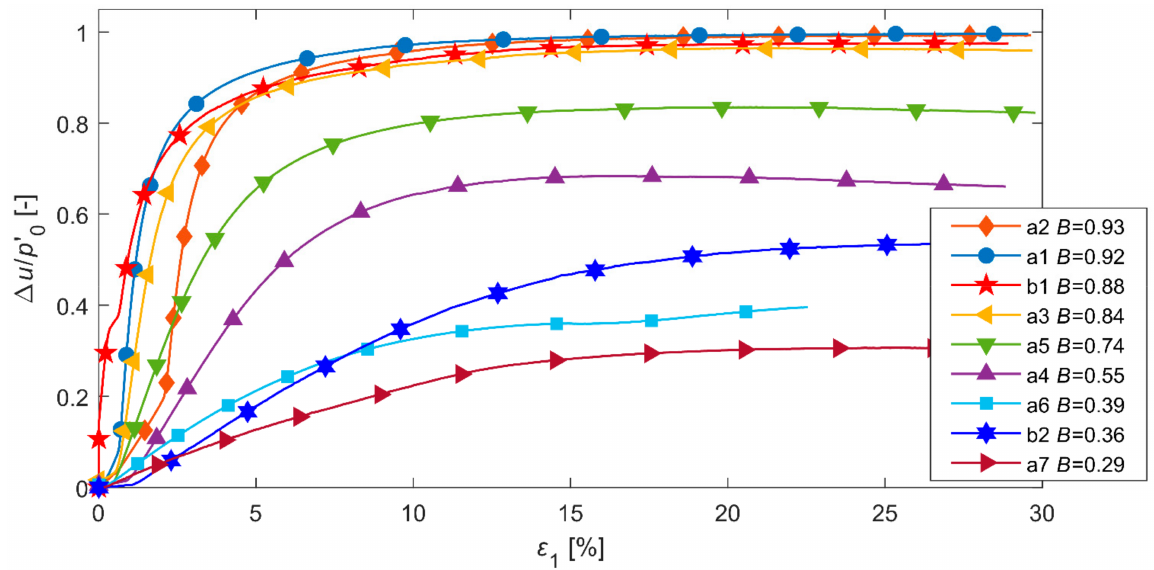
Figure 9. Response of OZM50 tailings at different levels of saturation: normalized excess pore pressure vs. vertical strain.